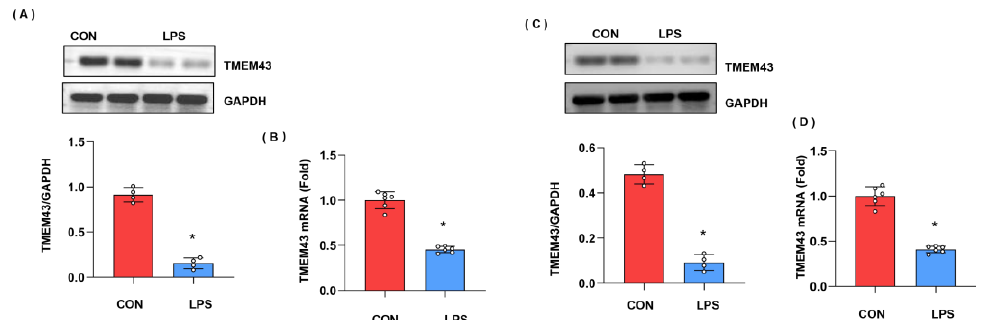
Figure 1. The expression level of TMEM43 in injured hearts. ( A ) Protein level of TMEM43 in mouse hearts challenged with LPS ( n = 4). ( B ) mRNA level of TMEM43 in mouse hearts challenged with LPS ( n = 6). ( C ) ( n = 6). Protein level of TMEM43 in cardiomyocytes challenged with LPS ( n = 4). ( D ) mRNA level of TMEM43 in cardiomyocytes challenged with LPS ( n = 6). * p < 0.05 vs. CON group.